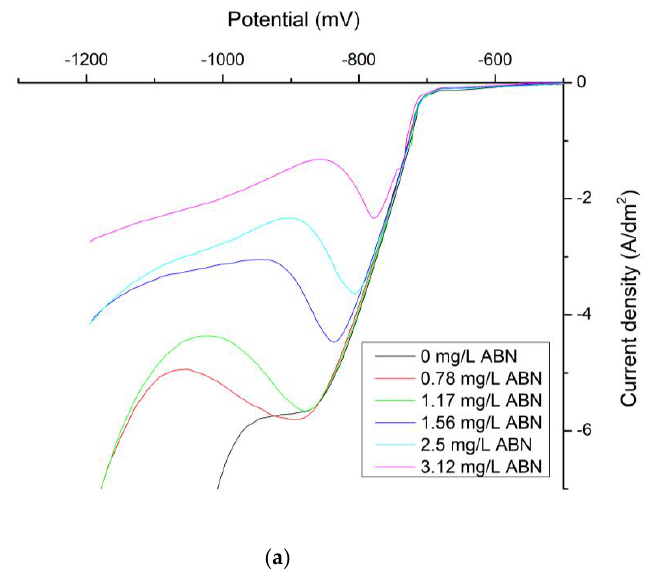
Figure 3. Cont. Figure 3.